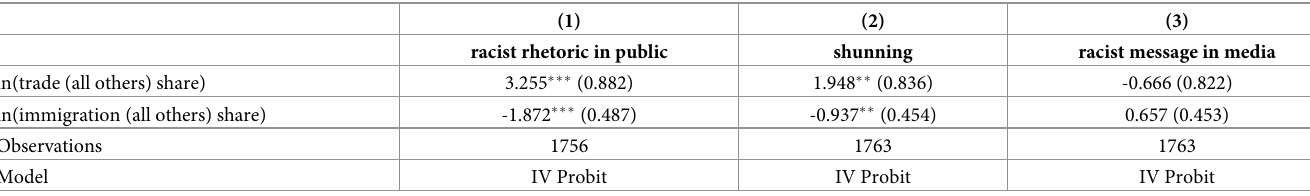
Table 7. Received discrimination by type (probit).